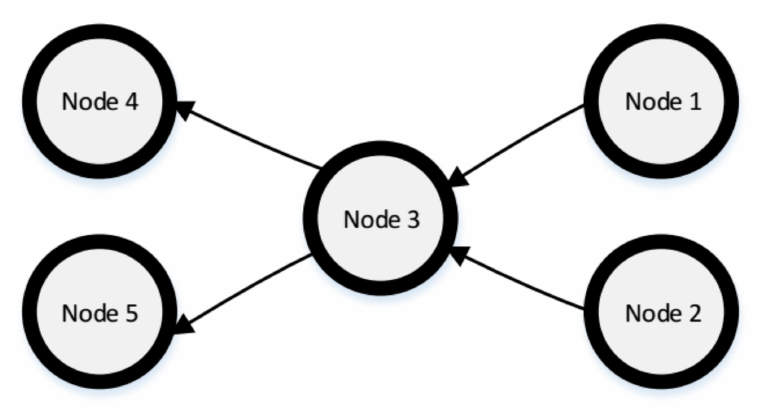
Figure 3. Topology 2 on a SC.